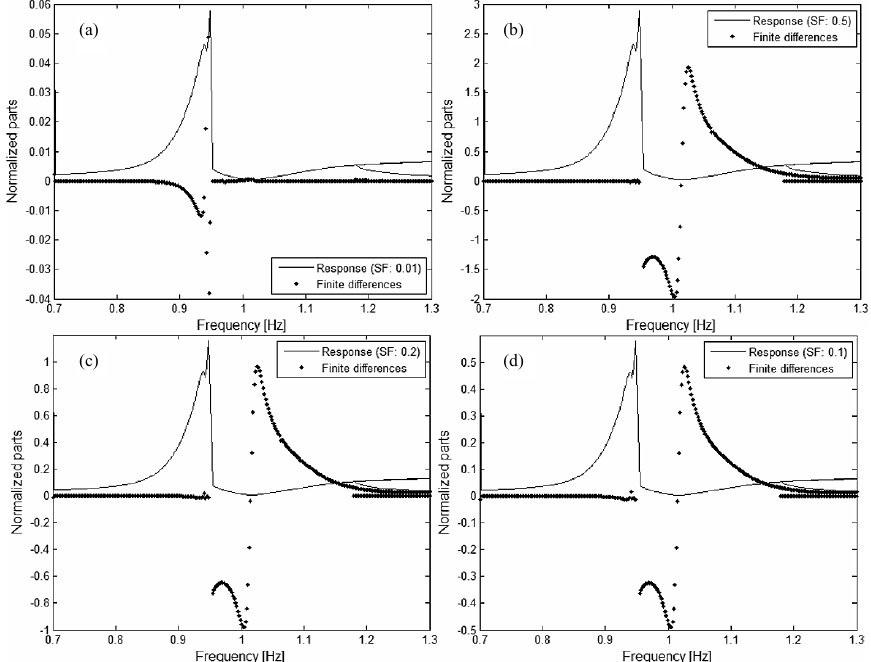
Fig. 2. Finite difference estimations of the Response H ( ω,p ) with respect to ε 1 : (a) ∆ ε 1 / ε 1 = 1%; (b) ∆ ε 1 / ε 1 = 5%; (c) ∆ ε 1 / ε 1 = 10%; (d) ∆ ε 1 / ε 1 = 20%.